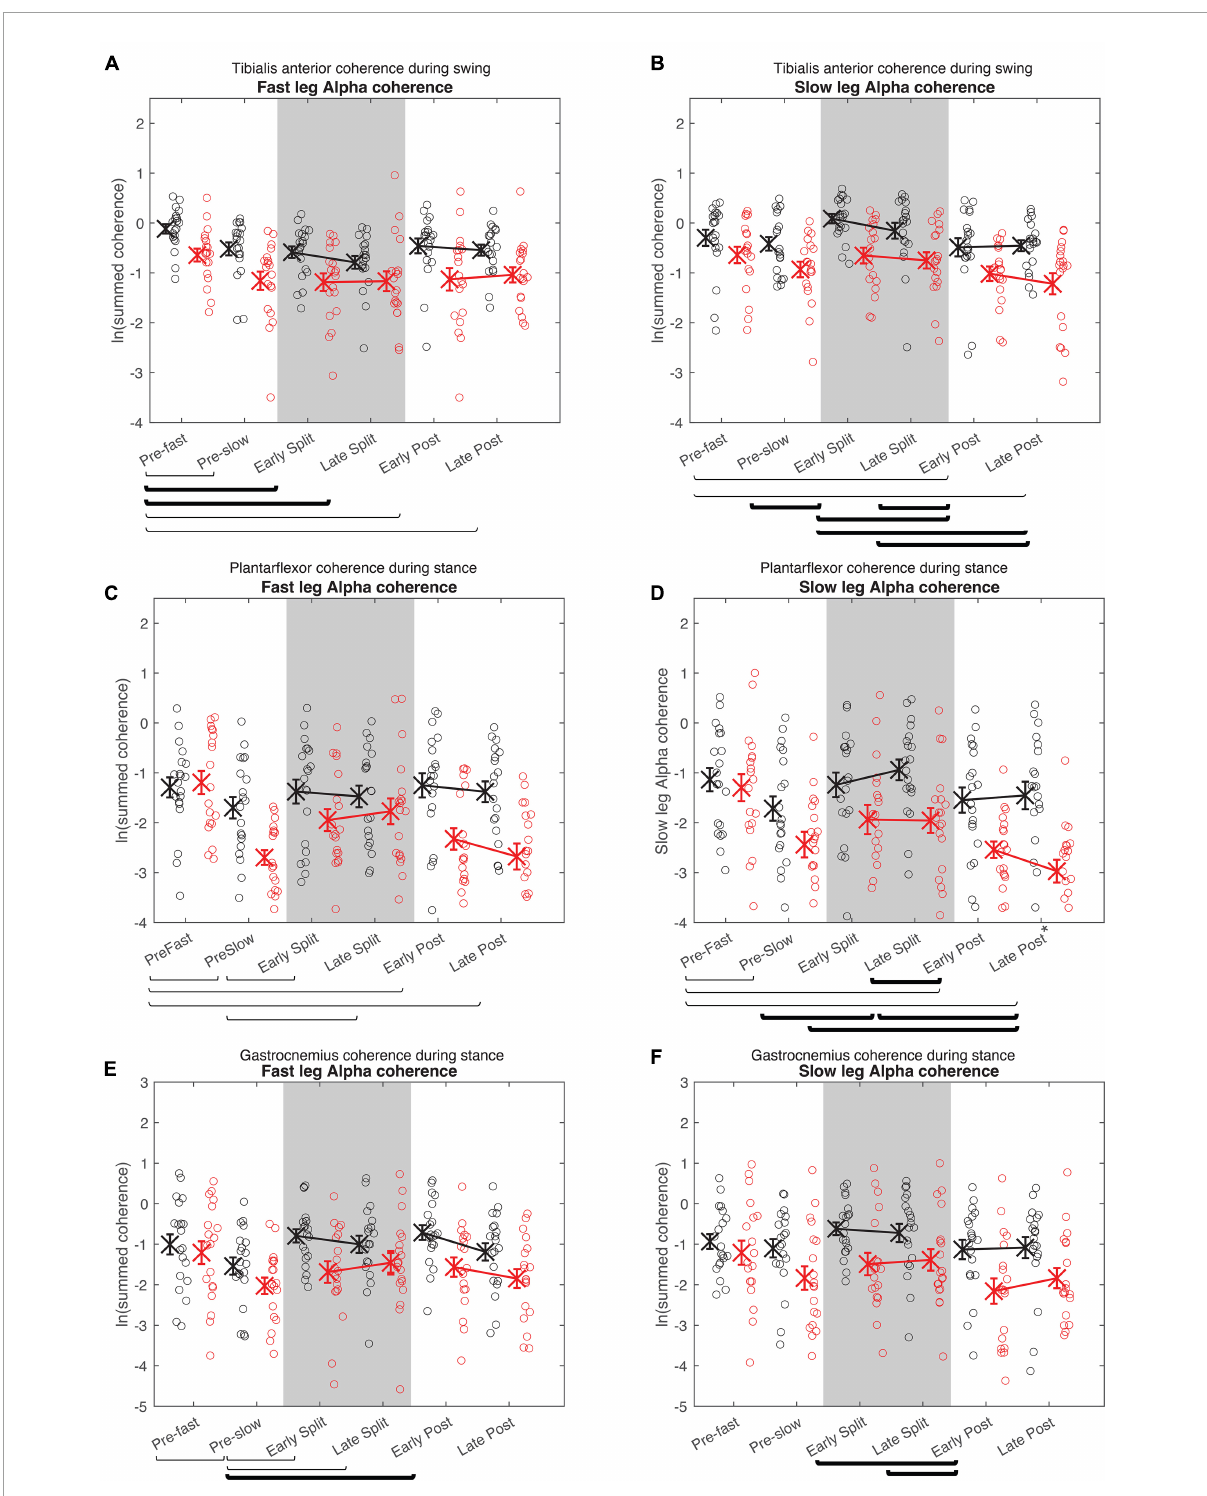
FIGURE6 Cumulative alpha electromyography-electromyography coherence. Intramuscular coherence between the distal and proximal tibialis anterior during swing phase (A,B) , intermuscular coherence between the medial gastrocnemius and soleus during stance phase (B,C) , and coherence between the medial and lateral gastrocnemius during stance phase (E,F) in the fast (A,C,E) and slow leg (B,D,F) . See Figure 5 caption for description of